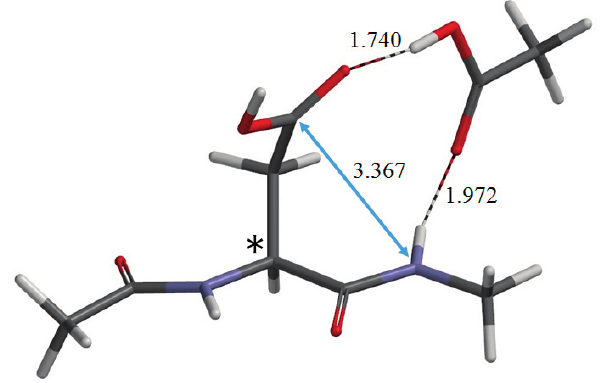
Figure 3. The geometries of ( a ) the reactant R (model compound, Figure 1) ( φ = − 162°, ψ = 162°, χ 1 = 72°) and ( b ) the succinimide product P ( φ = − 171°, ψ = − 141°, χ 1 = 136°).